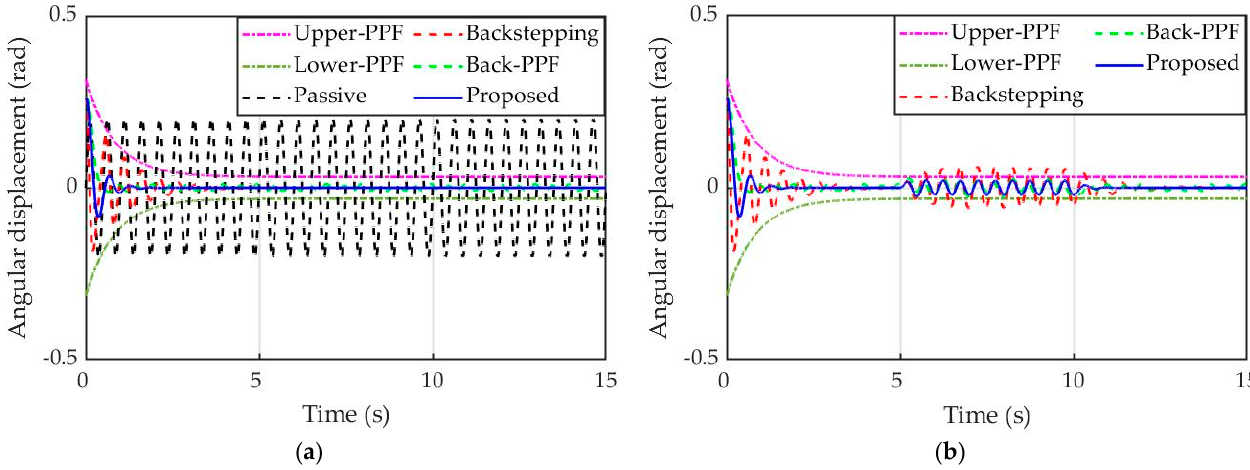
Figure 4. Sprung mass angular displacement: ( a ) Non-fault; ( b ) Actuator-fault.